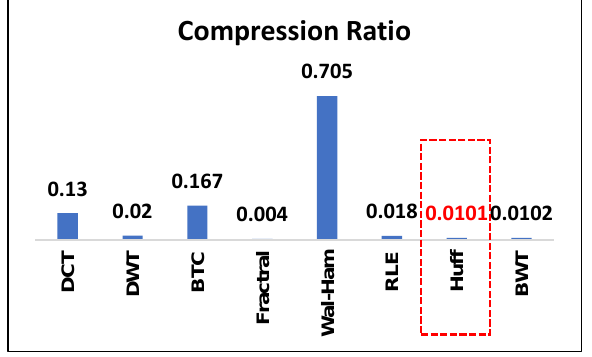
Figure 8. Performance on the basis of compressed ratio offered by different image compression algorithms Figure 9 examines the performance of algorithms based on Compression Time parameter. In lossy techniques, BTC algorithm takes less time while compressing the image i.e., 0.04 secs whereas DCT, DWT, and Fractal Encoding takes